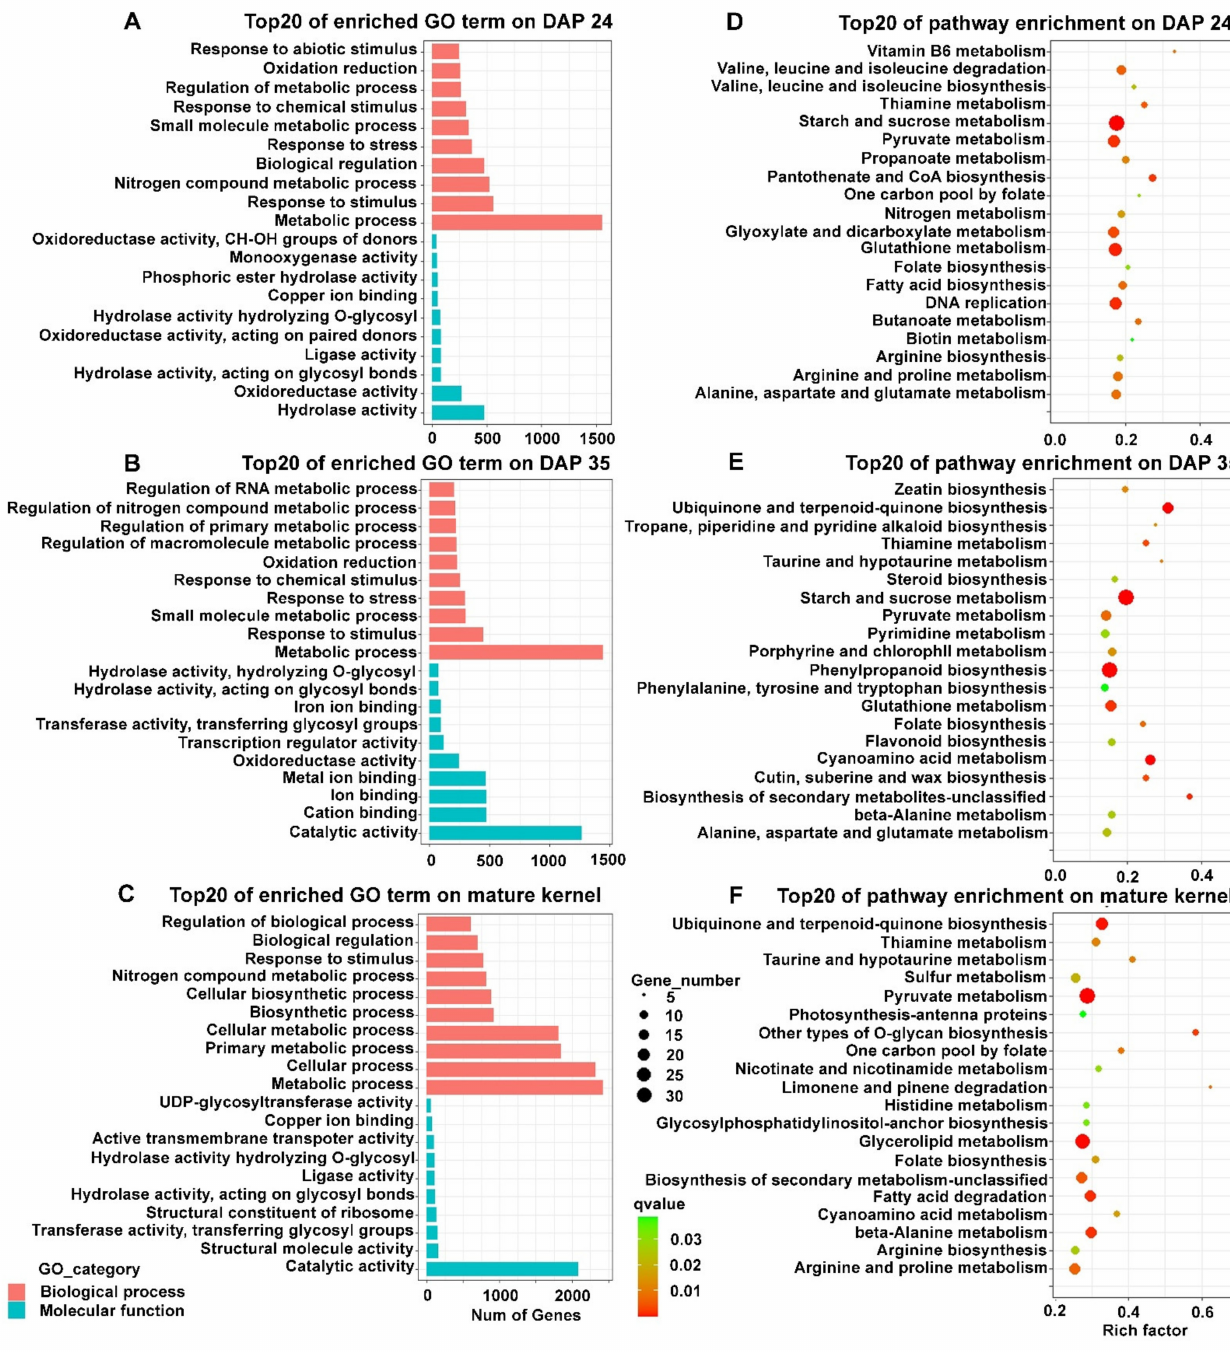
Figure 7. Bioinformatics analysis of DEGs in inbred-specific variation. ( A – C ) GO function analysis of DEGs on DAP 24, DAP 35, and mature kernel; ( D – F ) KEGG enrichment of DEGs on DAP 24, DAP 35, and mature